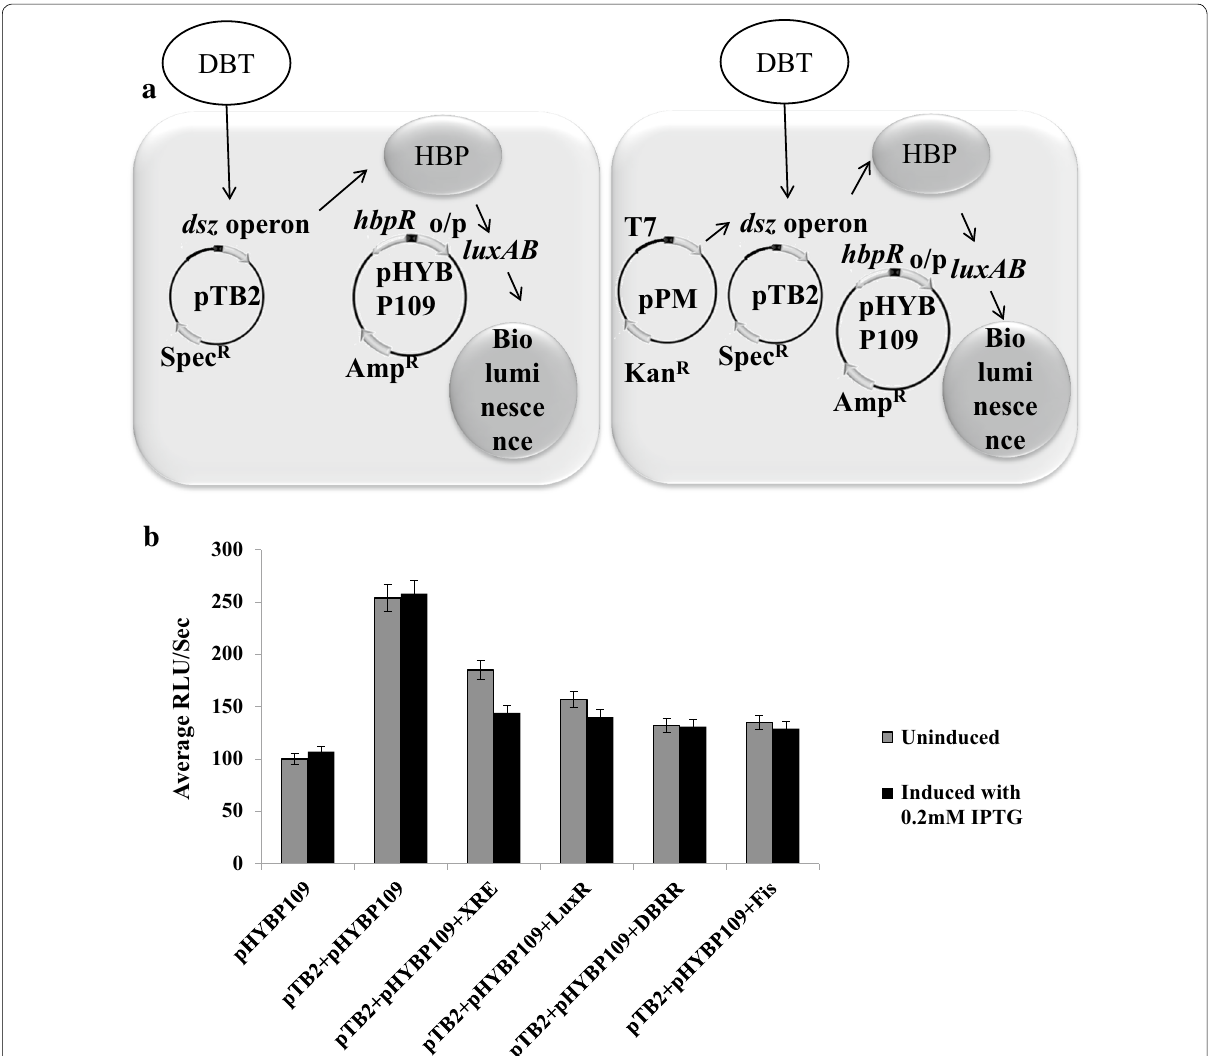
Fig. 2 Biodesulfurization activity in E. coli BL21(DE3) pLysS when cloned proteins is supplied in trans via plasmid as demonstrated by luciferase assay. a Schematic diagram of the assay; b Graph showing that there is no increase in activity of the dsz operon, rather they are slightly reduced. The grey bar indicates the uninduced sample and the black bar indicates the luminometer reading when the cells are induced with 0.2 mM IPTG.